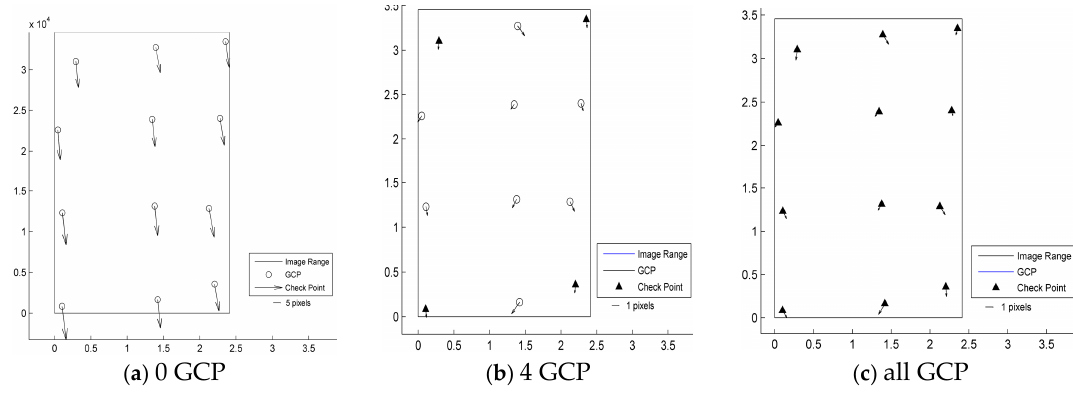
Figure 7. Residual distributions of check points of the SS mode orientation for Mount Song: ( a ) 0 GCP; ( b ) 4 GCP; ( c ) all GCP.